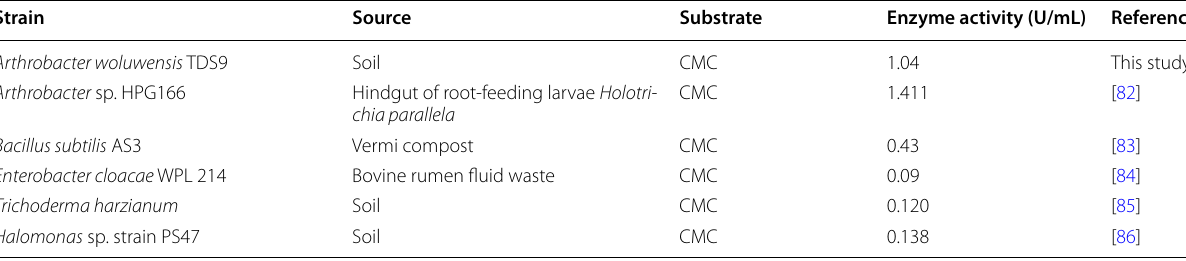
Table 3 Comparison of CMCase enzyme production using CMC as the carbon source Strain Source